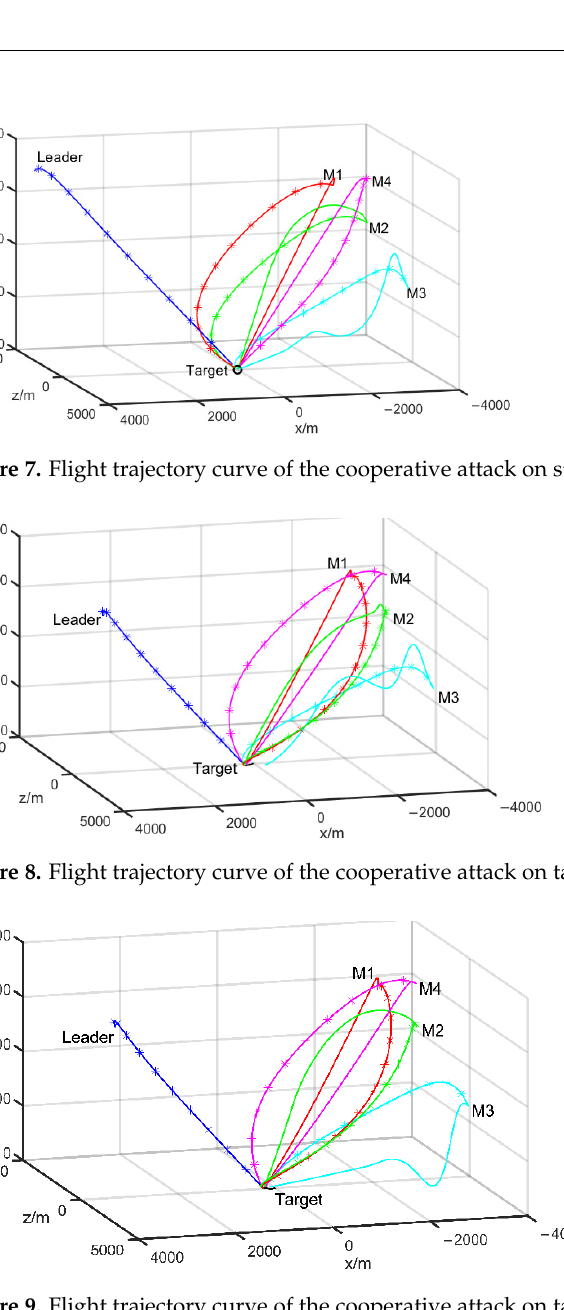
Figure 9. Flight trajectory curve of the cooperative attack on target 3.